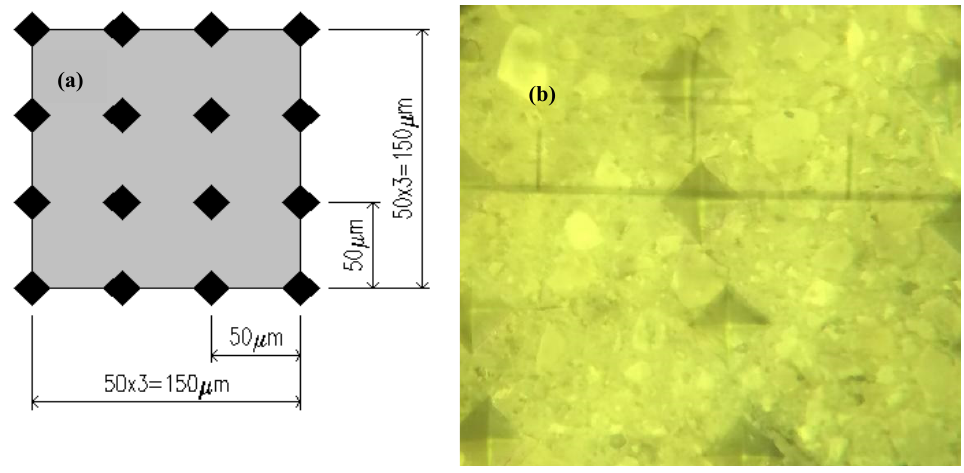
Figure 9. ( a ) Design of the microhardness lattice. ( b ) Microhardness indentation area.